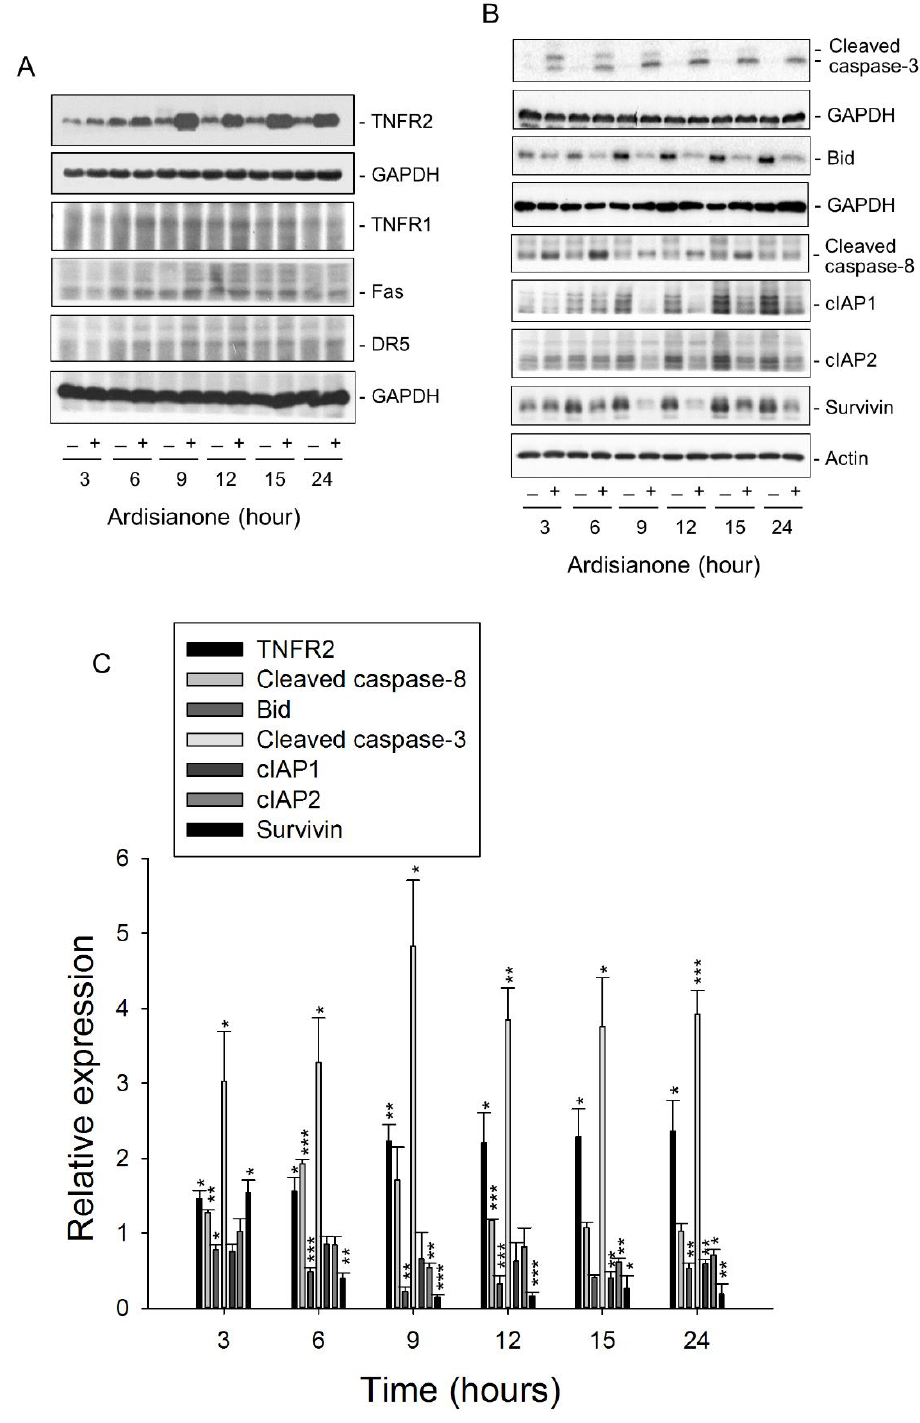
Figure 3. Effect of ardisianone on the expression of several proteins. HL-60 cells were incubated with or without ardisianone (2 µ M) for the indicated times. After the treatment, the cells were harvested for the detection of protein expression of death receptors ( A ) and several proapoptotic and antiapoptotic protein expressions ( B ) using Western blotting analysis. ( C ) Expression levels were quantified using Image Lab Software 6.0 (BIO-RAD), and protein expression relative to ardisianone-free control was demonstrated. Data are expressed as mean ± SEM of three determinations. * p < 0.05, ** p < 0.01, and *** p < 0.001 compared with the control.